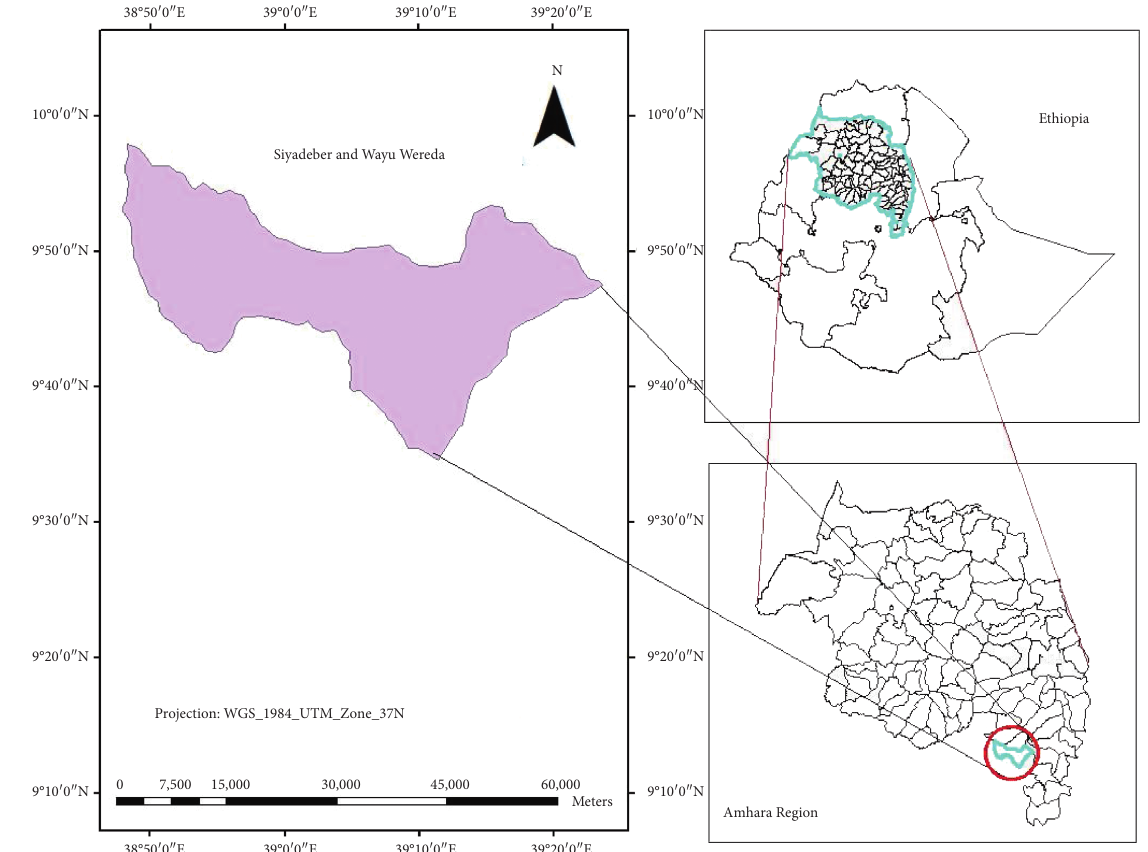
Figure 1: Map showing the study area, Siyadeber and Wayu District, North Shewa, Amhara region, Ethiopia, 2019.